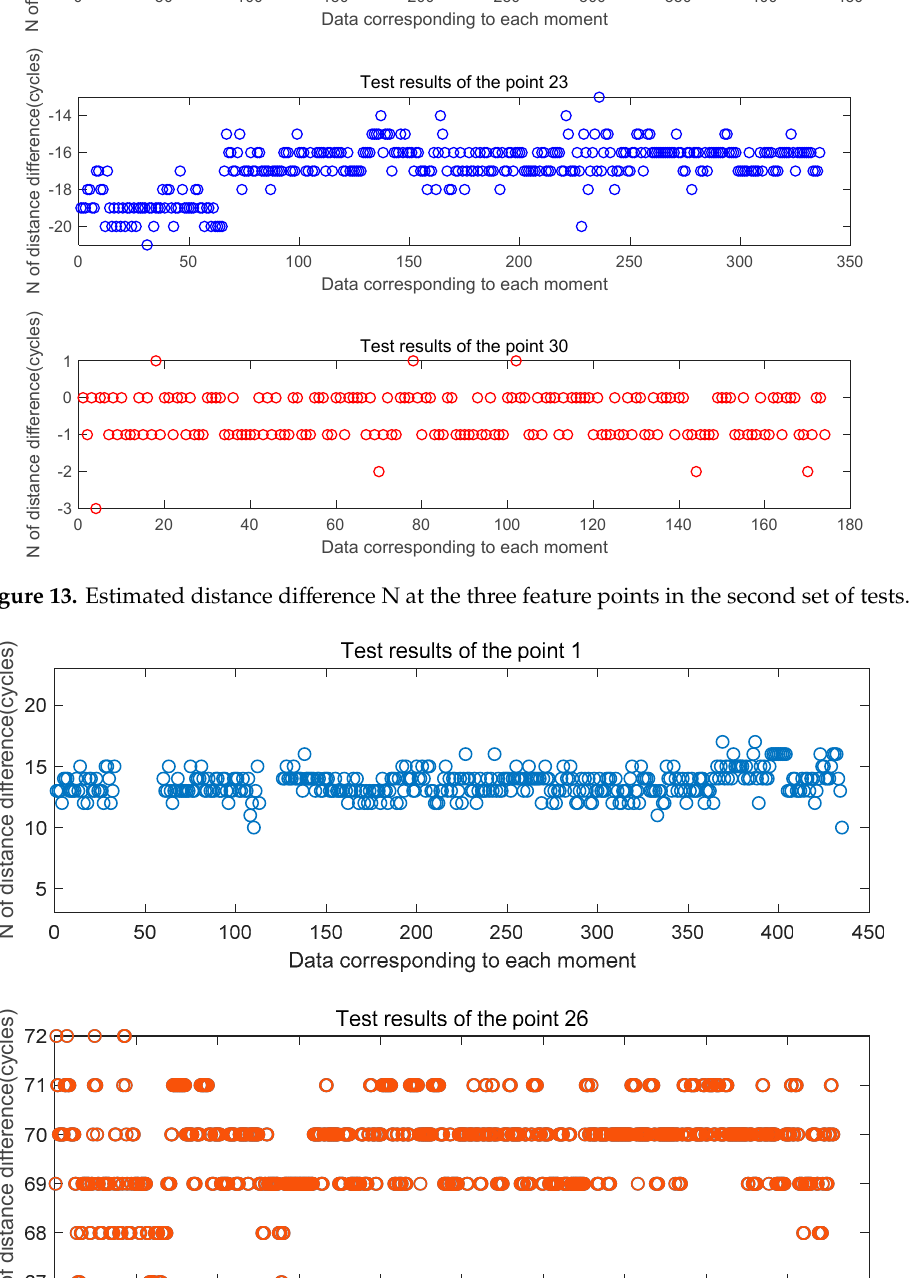
Figure 15. Estimated distance difference N at the three feature points in the second set of tests.